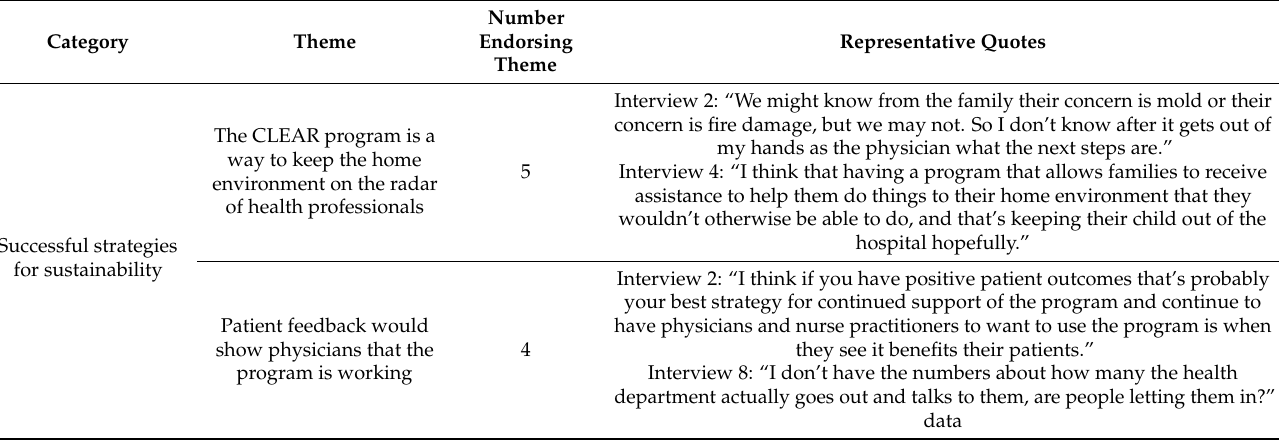
Table 1. Health professionals’ ideas for promoting sustainability and challenges to the sustainability of the CLEAR